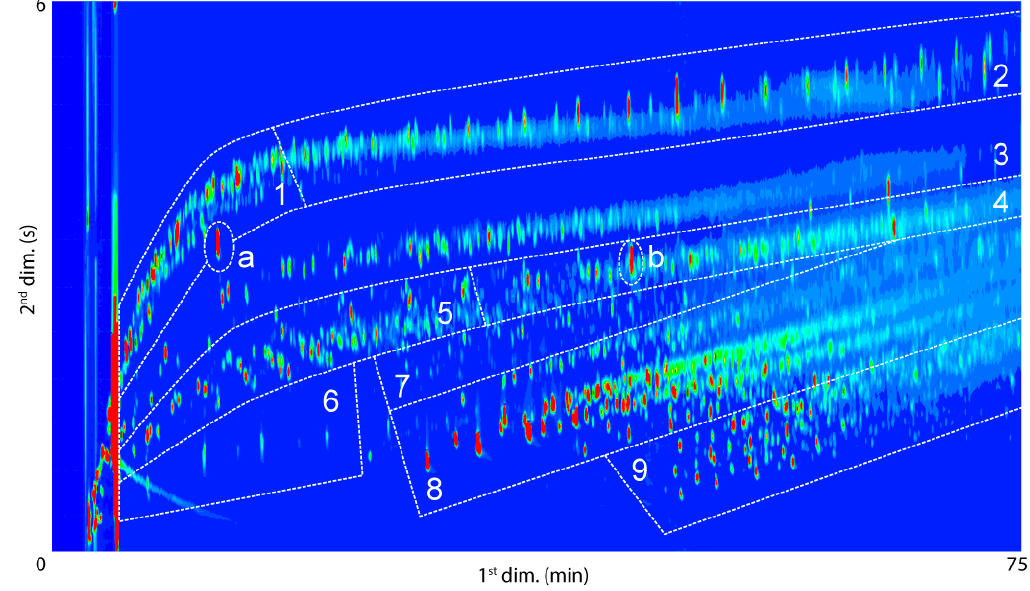
Figure 6. Typical GC × GC-FID chromatogram for representative product oil from PL [29].